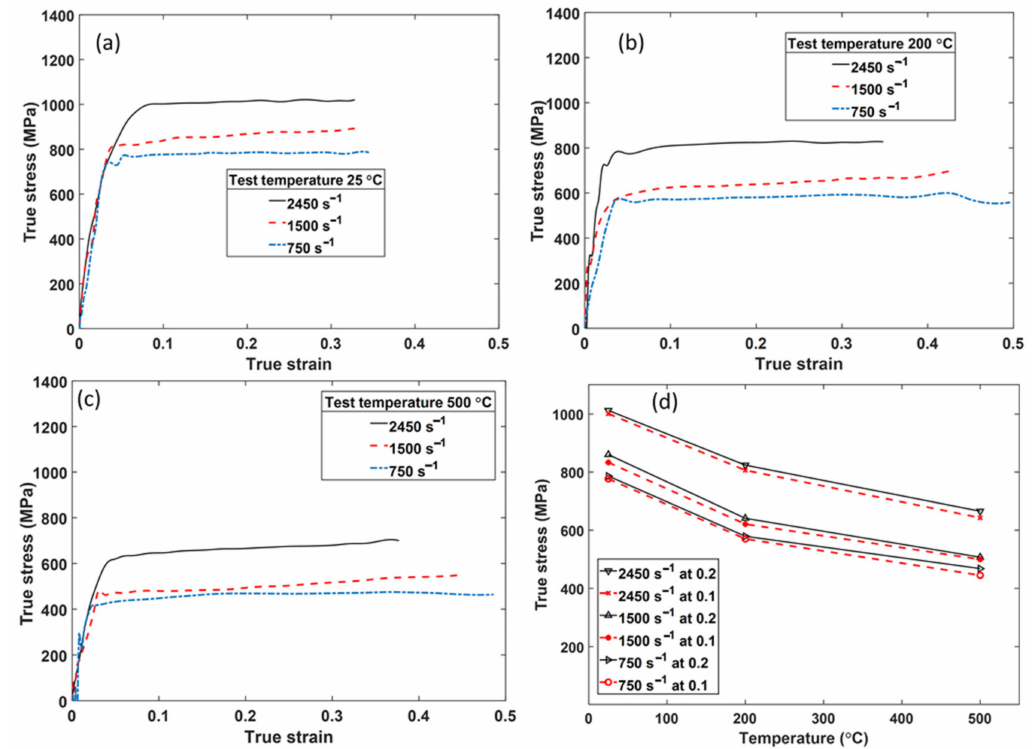
Figure 9. The true stress- strain curves ( a – c ) at different strain rates and temperatures, and ( d ) true stress vs. temperature curves at different strain rates and at strains of 0.1 and 0.2, all for samples